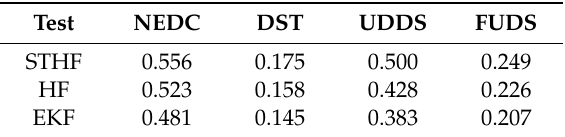
Table 8. The running time of STHF, HF, and EKF under different test